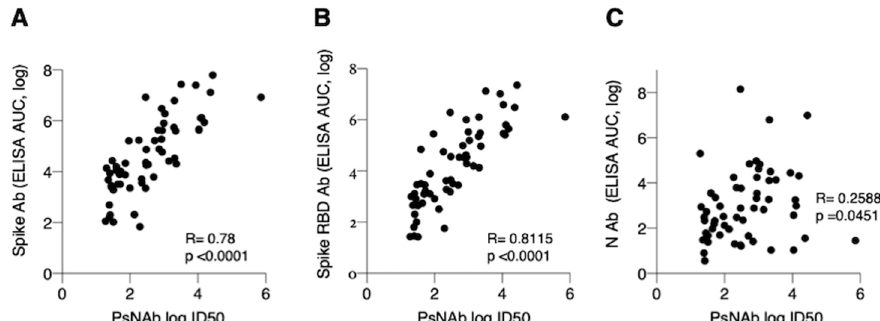
Figure 4. Correlation of PsNAb to Ab measured by ELISA assays. Correlation of ID50 NAb and ( A ) spike (r = 0.78, p < 0.0001), ( B ) spike RBD (r = 0.81, p < 0.0001) and ( C ) nucleocapsid ( r = 0.26, p = 0.05) AUC measured by ELISA.